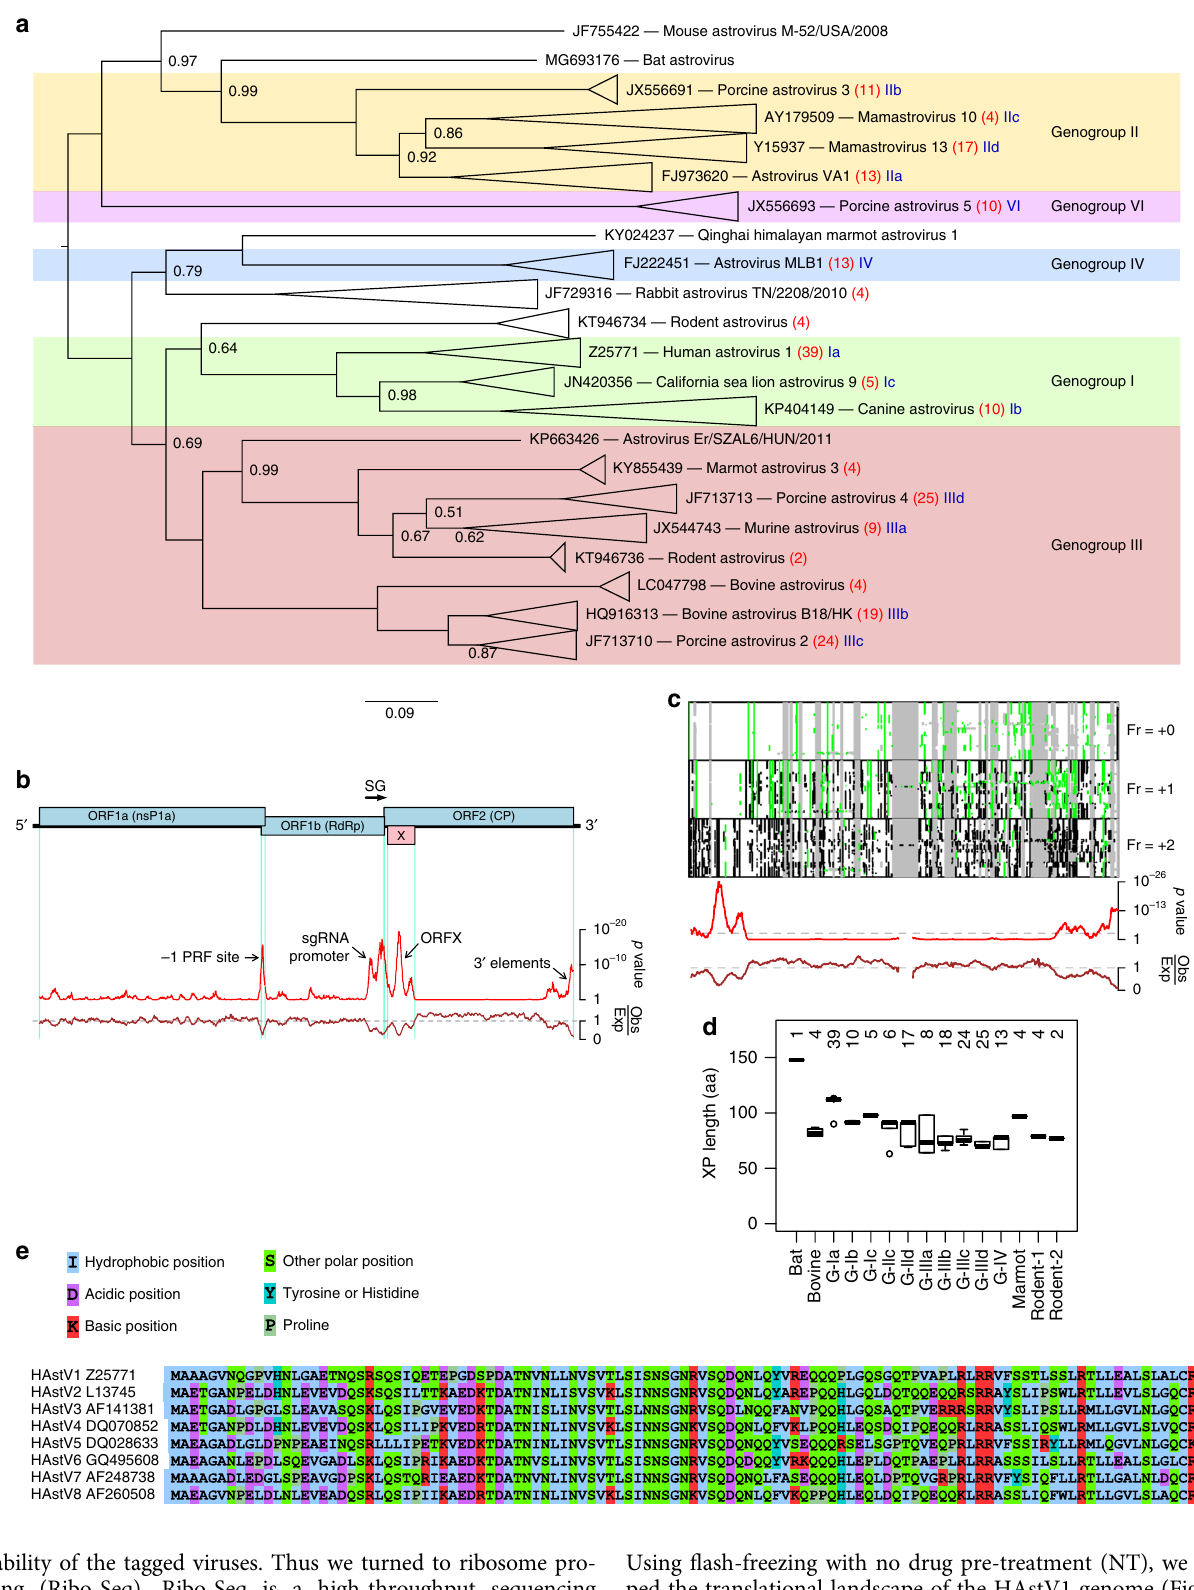
Using fl ash-freezing with no drug pre-treatment (NT), we map- ped the translational landscape of the HAstV1 genome (Fig. 2a). ORF2 is translated at ~9× the level of ORF1a, whereas ORF1b is translated at ~25% the level of ORF1a, indicating a ribosomal frameshifting ef fi ciency of ~25%. The higher expression of ORF2 is likely a result of higher levels of sgRNA than gRNA in the translation pool. To identify translation initiation sites,